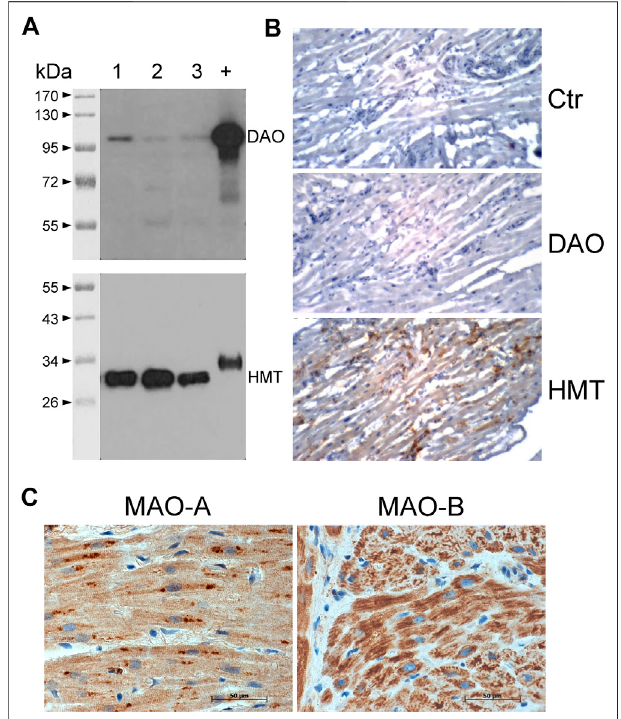
FIGURE8| Detectionofhistamine-metabolizingenzymesinhumanatria by immunohistochemical staining and immunoblotting. (A) Diamine oxidase (DAO, 105 kDa) and histamine-N-methyltransferase (HMT, 33 kDa) were detected on blots of 10 µg total protein from human atrial homogenates from three patients(lanes 1 – 3) separated on 10%(DAO) or 12.5% (HMT) SDS polyacrylamide gels using speci fi c monoclonal antibodies. +, positive control of 400 ng human kidney homogenate; kDa, molecular weight markers with sizes of proteins in kDa. (B) Immunohistochemical stainings of DAO and HMT on thin sections of human atrial specimens are presented. Sections were incubated without speci fi c antibody (Ctr) or with speci fi c monoclonal antibodiesforDAOandHMT. (C) ImmunohistochemicallocalizationofMAO-A and MAO-B in the human atrial myocardium. (B,C) Immunocomplexes